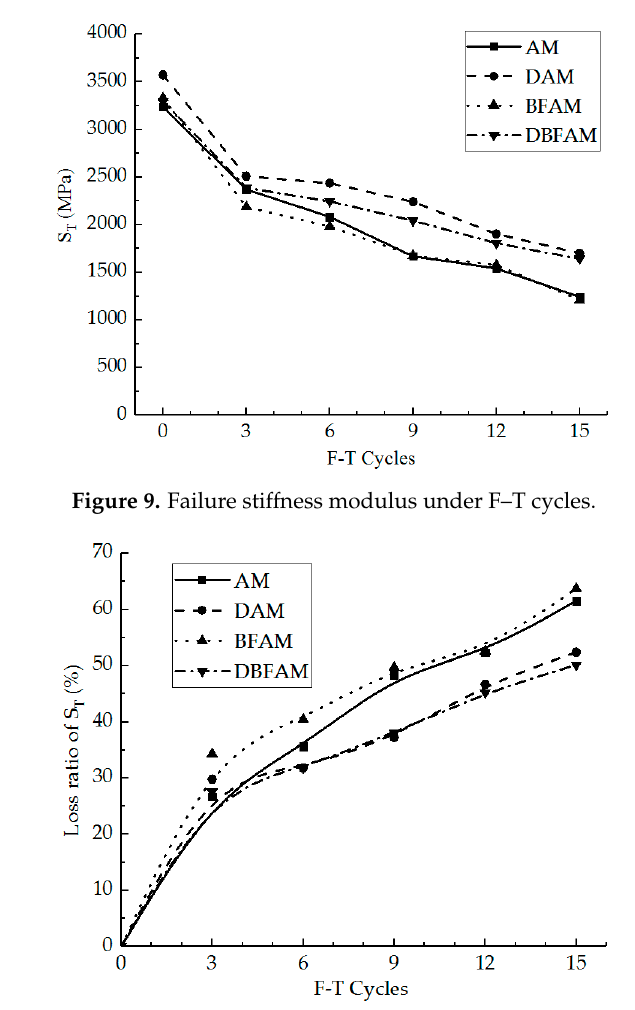
Figure 10. Loss ratio of failure stiffness modulus under F–T cycles.